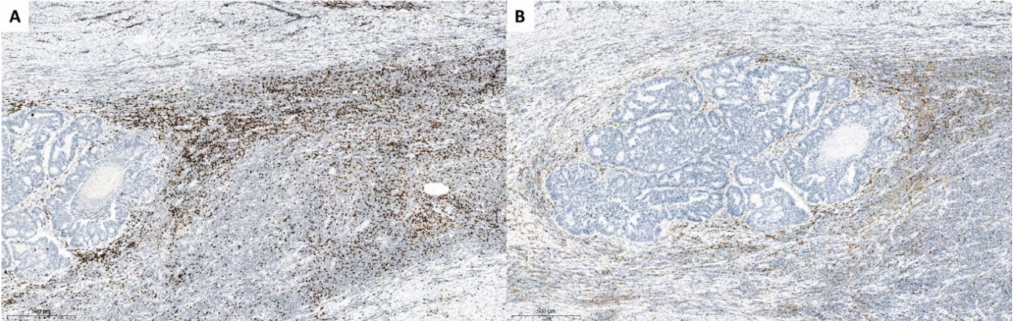
Figure 4. Resection specimen of the same patient as in Figure 3 of a colon carcinoma with predominance of CD8 ( A ) over CD4 ( B ) positive lymphocytes.